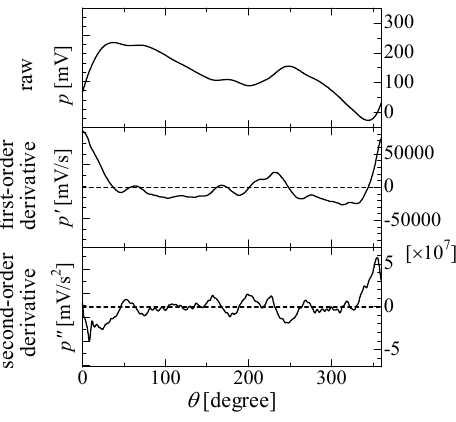
Fig. 9 Phase-averaged signals (FACE MODE).